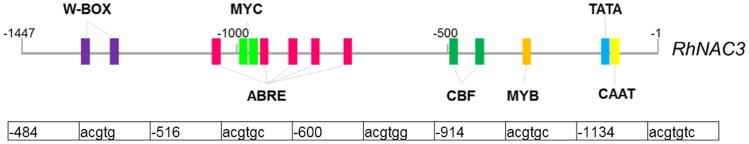
Schematic representation of the RhNAC3 promoter.The major stress-related cis-acting elements in the 1447 bp promoter of RhNAC3 are shown. The position and putative sequences of ABRE elements are listed.